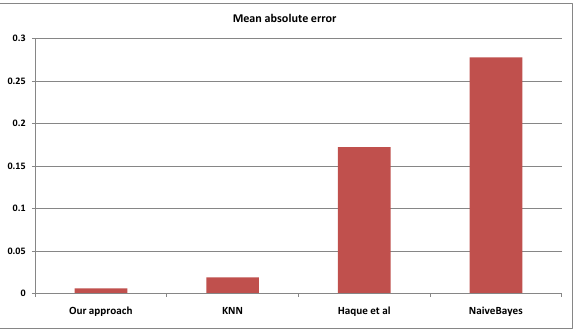
Figure 9. Mean absolute error for our approach when compared to 3 relevant alternative approaches in the